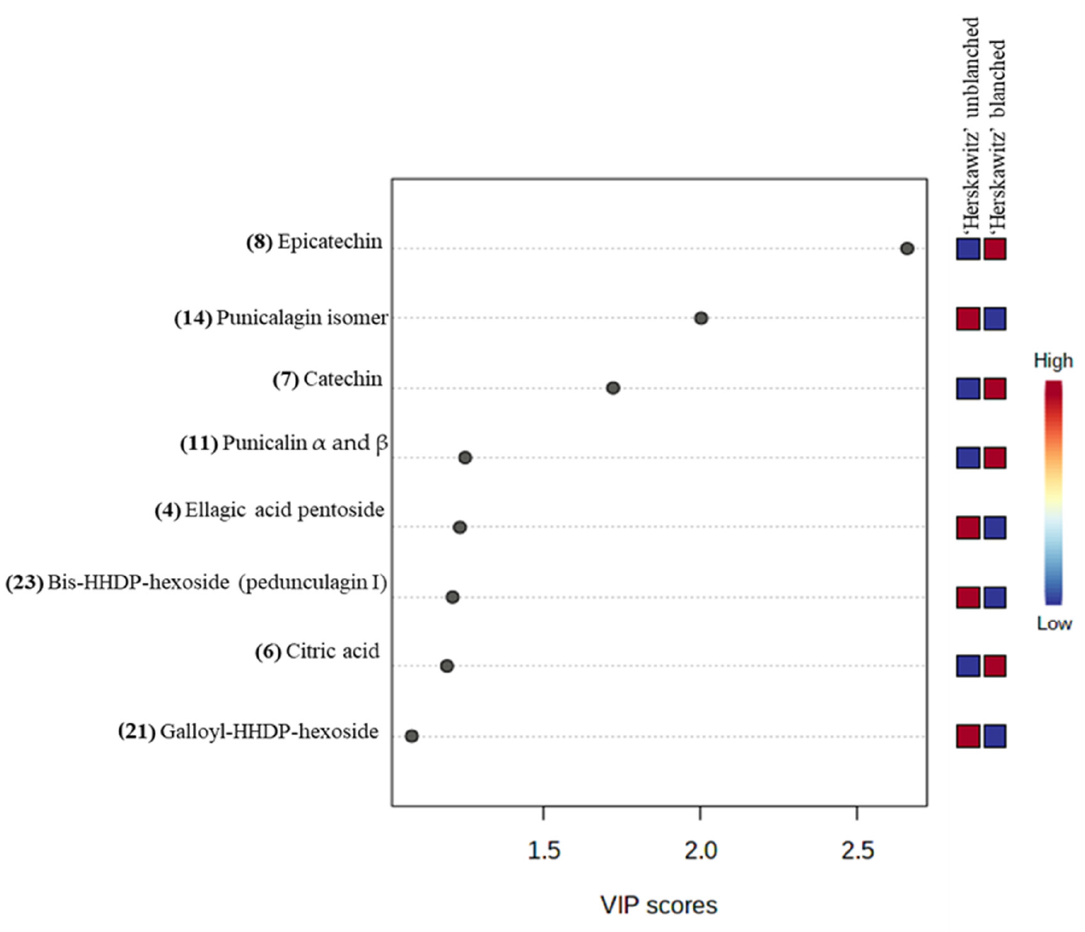
Figure 4. Variable importance in the projection (VIP) plot showing the eight most statistically significant metabolites linked to the changes in ‘Herskawitz’ unblanched and ‘Herskawitz’ blanched peel extracts.